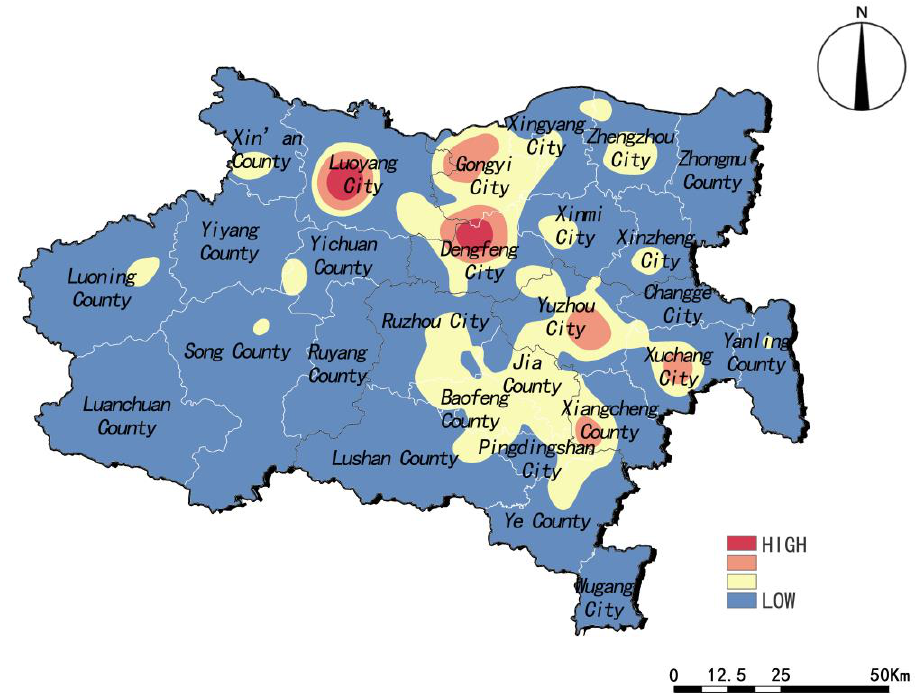
Figure 7. Kernel density of historical buildings in the Songshan region.